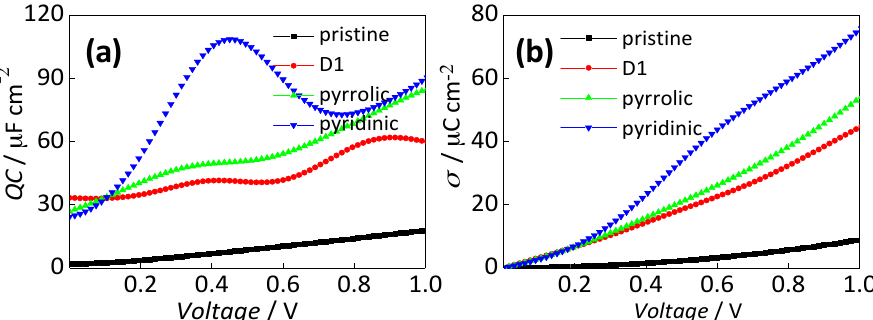
Figure 6. Energy storage performance of pristine, D1 defected graphene and graphene with pyrrolic N and pyridinic N. ( a ) quantum capacitance (QC) and ( b ) excessive surface charge density (ESCD).